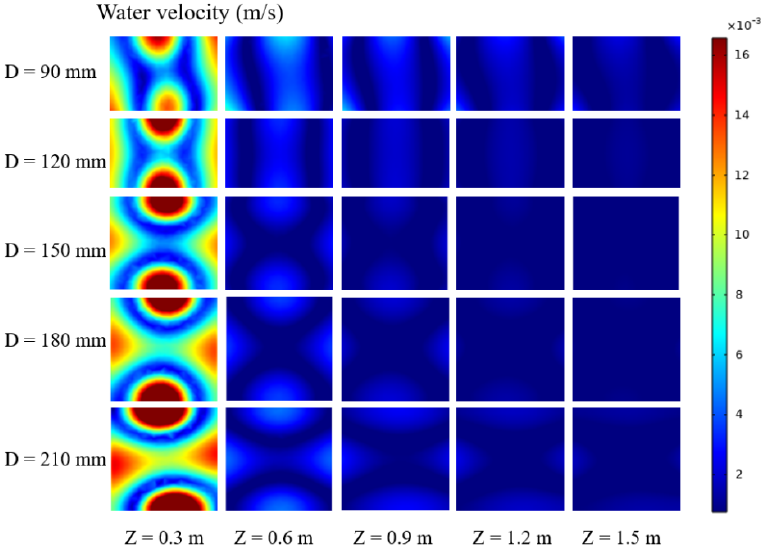
Figure 15. Cloud map of the water velocity variation along the horizontal direction at different orifice spacings.